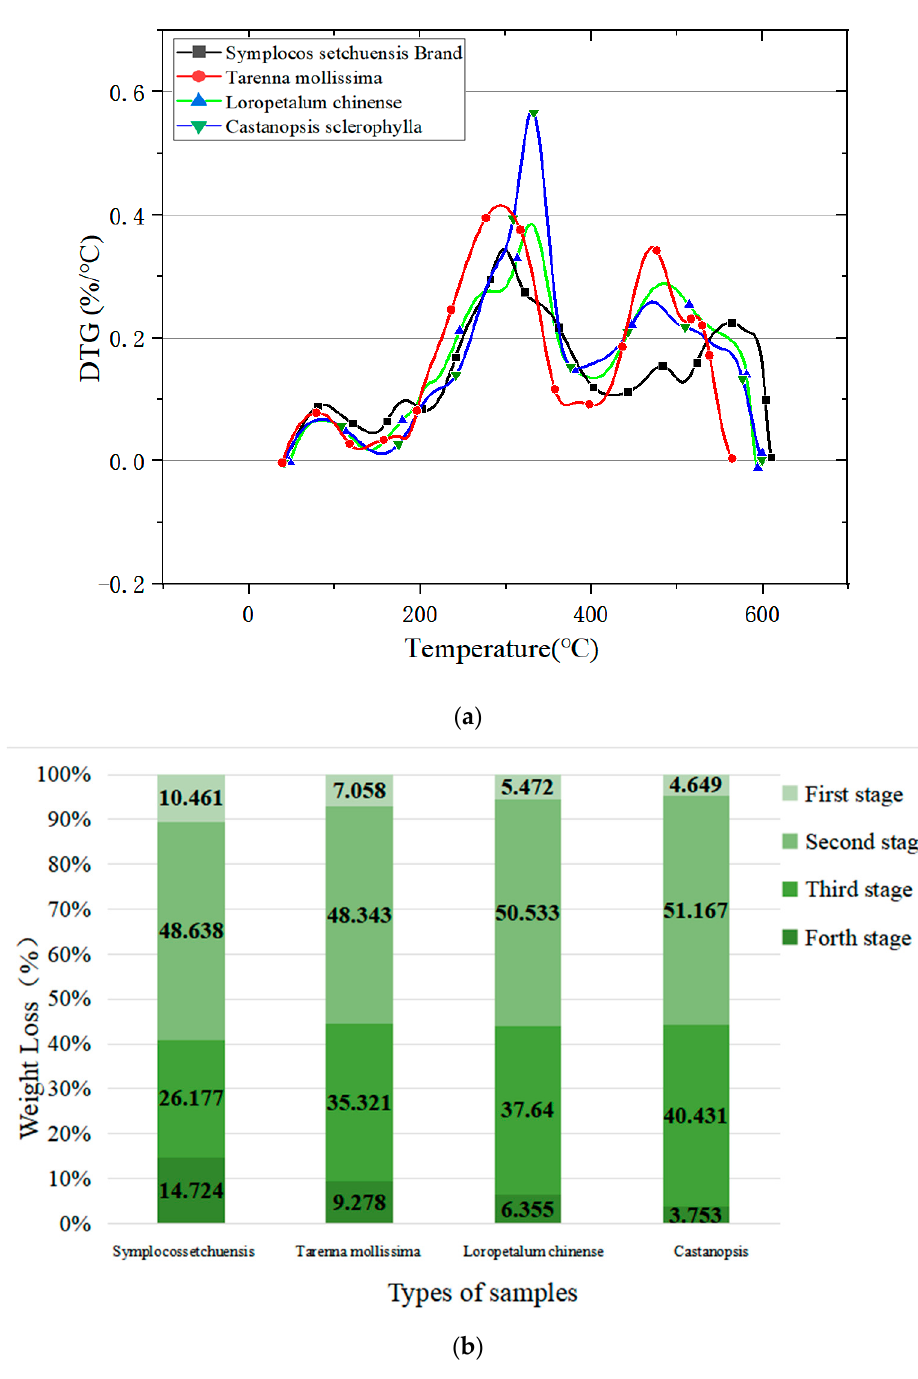
Figure 3. ( a ) Results of DTG for the four studied leaf species. ( b ) Weight loss fraction of each